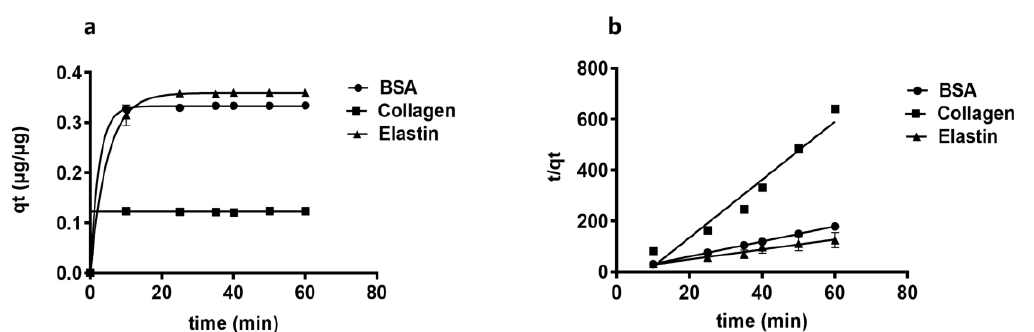
Figure 4. Kinetic study of protein adsorption and the GO adsorption capacity for BSA, collagen and elastin: ( a ) Representation of adsorption capacity (q t ) over time. ( b ) Pseudo-second-order kinetic model.